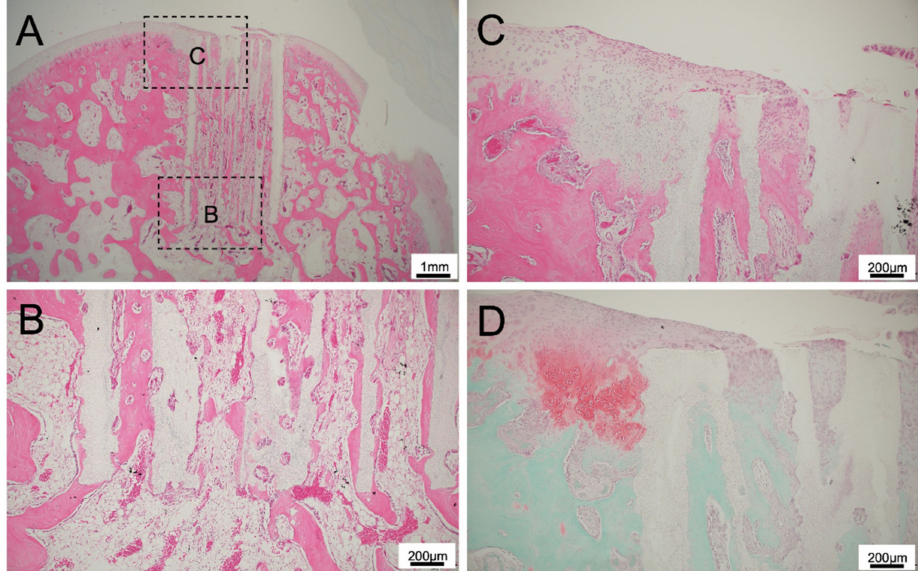
Figure 3. ( A ) Histological finding of 300TCP with TGF- β without Matrigel at low power magnifica- tion. ( B , C ) Histological finding of 300TCP with TGF- β without Matrigel at high power magnification. At the site where the TCP contacted with the existing bone marrow, bone formation was observed to be continuous from the existing bone. In the superficial layer of the TCP, fibrous connective tissue formation was present, and the formation of thin cartilage tissue was observed in the fibrous connective tissue formed in the TCP surface layer. ( D ) Safranin O staining showed slight cartilage formation in the superficial layer of the TCP.